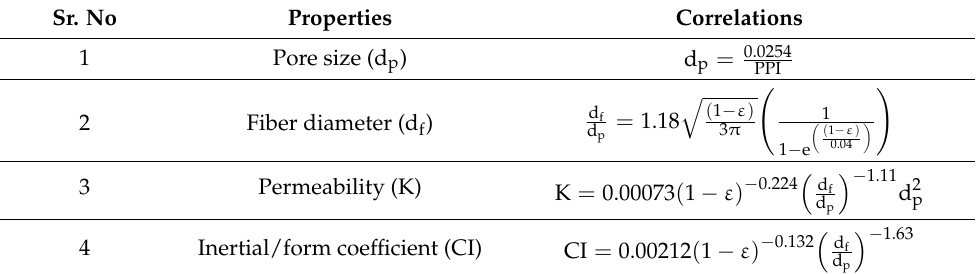
Table 5. Properties and its correlations of metal foam [11,40].